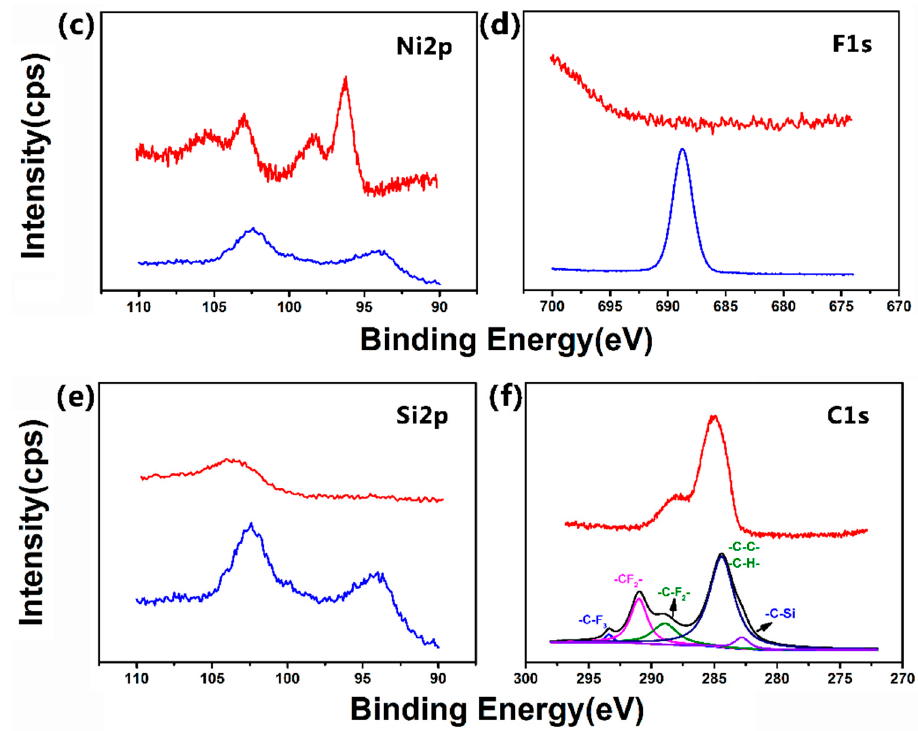
Figure 4. XPS spectra before and after modification of the Co–Ni coating deposited under the applied potential at − 1.7 V in the mixed solution: ( a ) XPS survey spectra; ( b ) Co 2 p spectra; ( c ) Ni 2 p spectra; ( d ) F 1 s spectra; ( e ) Si 2 p spectra; and ( f ) high resolution C 1 s spectra.